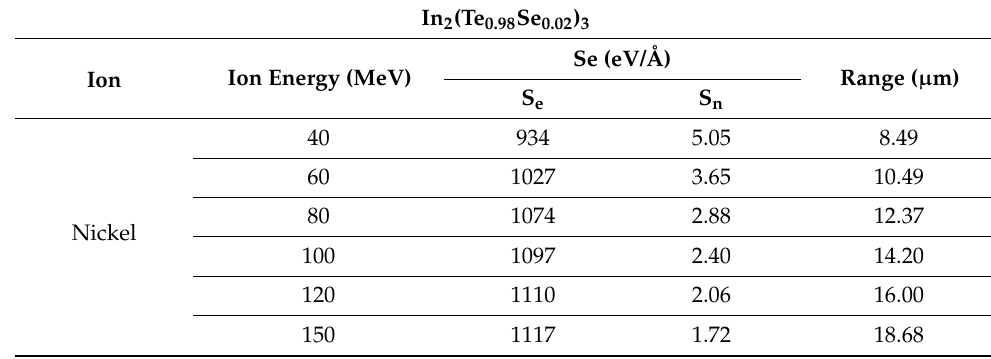
Table 1. Displays the calculated electronic energy loss (S e ) using SRIM